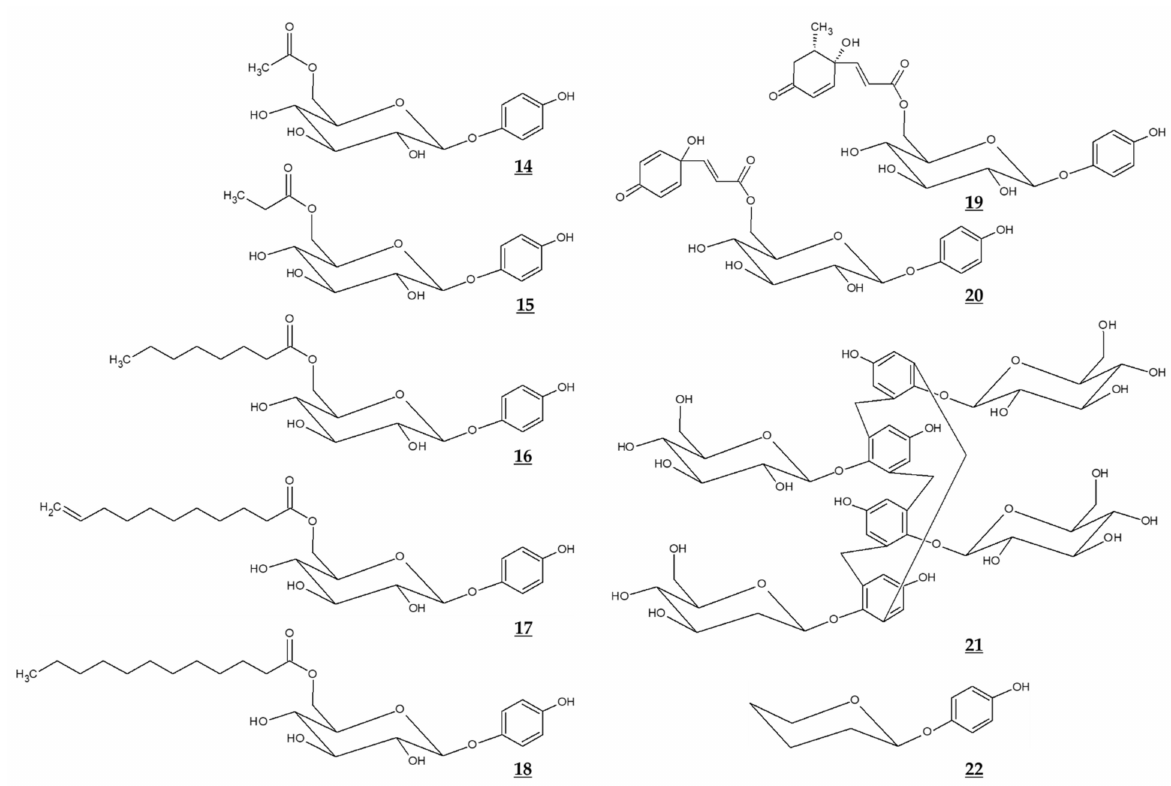
Figure 4. Chemical structures of various derivatives of arbutin and related